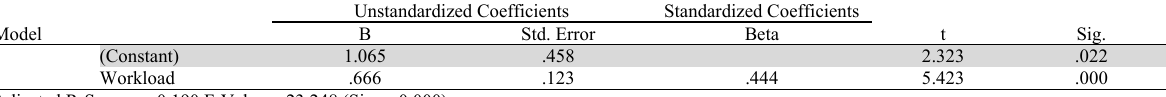
The summary of the results of testing the fifth